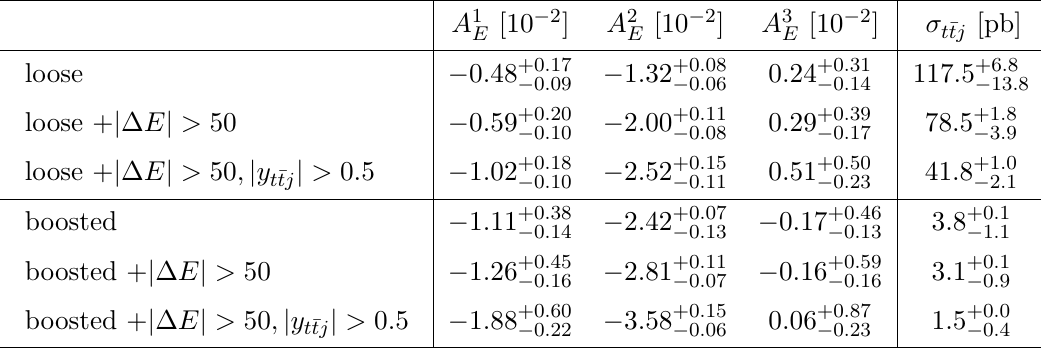
Table 1 . Parton-level predictions at NLO QCD for the energy asymmetry A opt in three (cid:18) j bins E p and for the cross section (cid:27) (cid:2) B 1 ‘ at the LHC with s = 13 TeV. The results are shown in six t (cid:22) tj selection regions; the quoted uncertainties are due to scale variations. Cuts in j (cid:1) E j are in units of